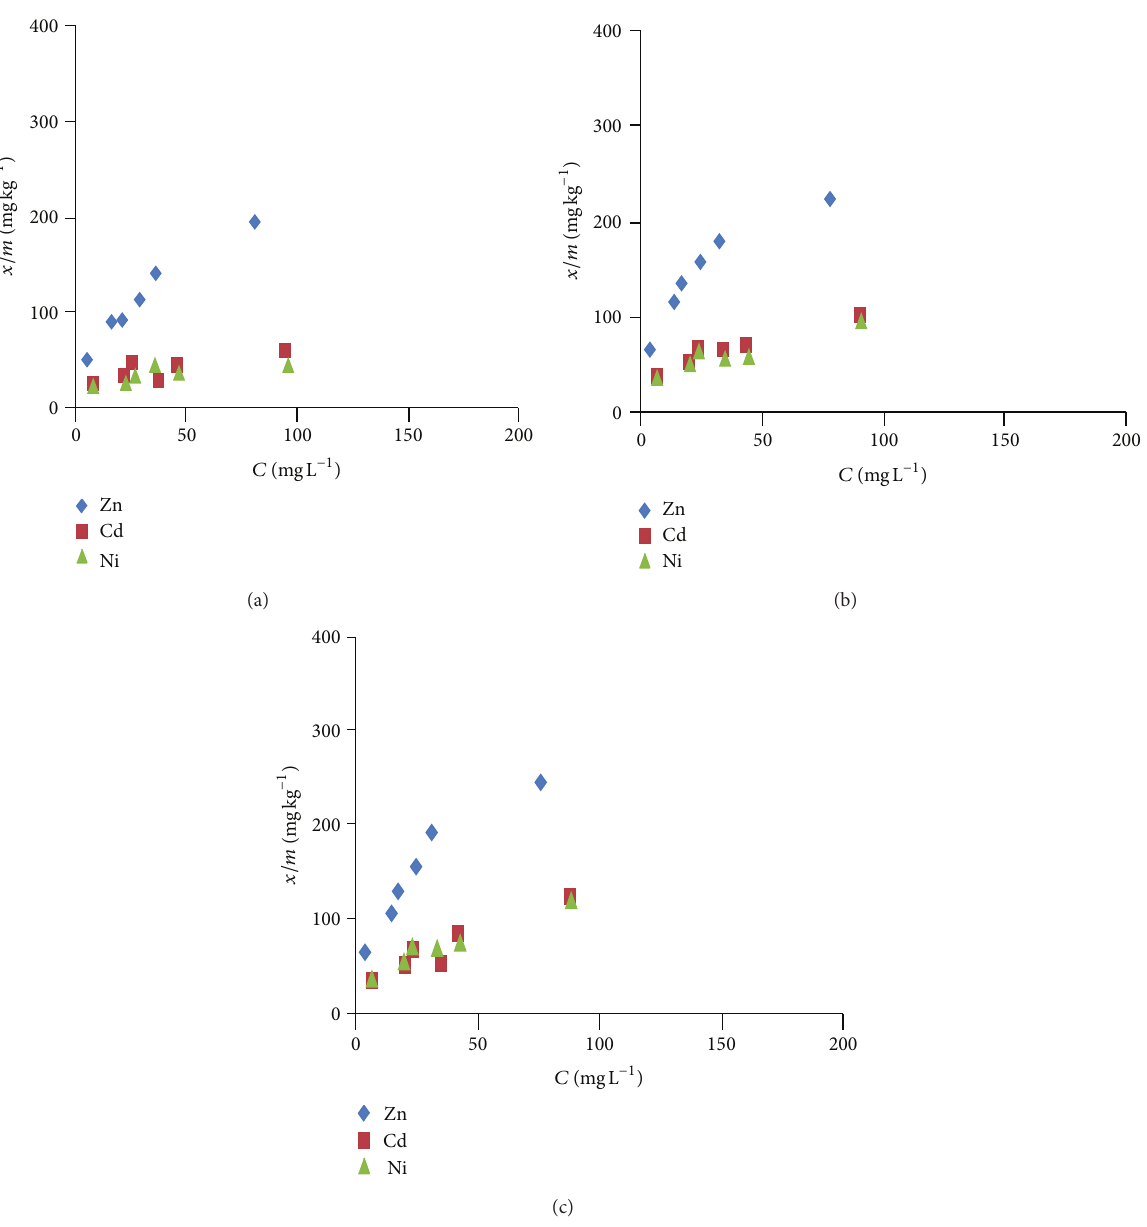
Figure 2: Competitive adsorption isotherms of Zn, Cd, and Ni in soil control (a), T 2 (b), and T 3 (c) samples. Data are means of triplicate determinations. Coefficients of variation were less than 10%. Table 3: The Freundslich constants and 𝑅 2 values obtained from the Freundlich isotherm in single and multimetal